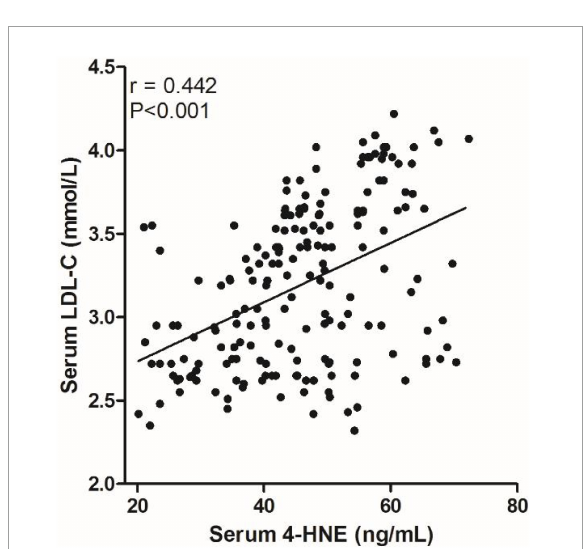
FIGURE3 Scatter plot suggests a positive correlation between serum 4-hydroxynonenal (4-HNE) and low-density lipoprotein cholesterol (LDL–C) in primary cerebral infarction